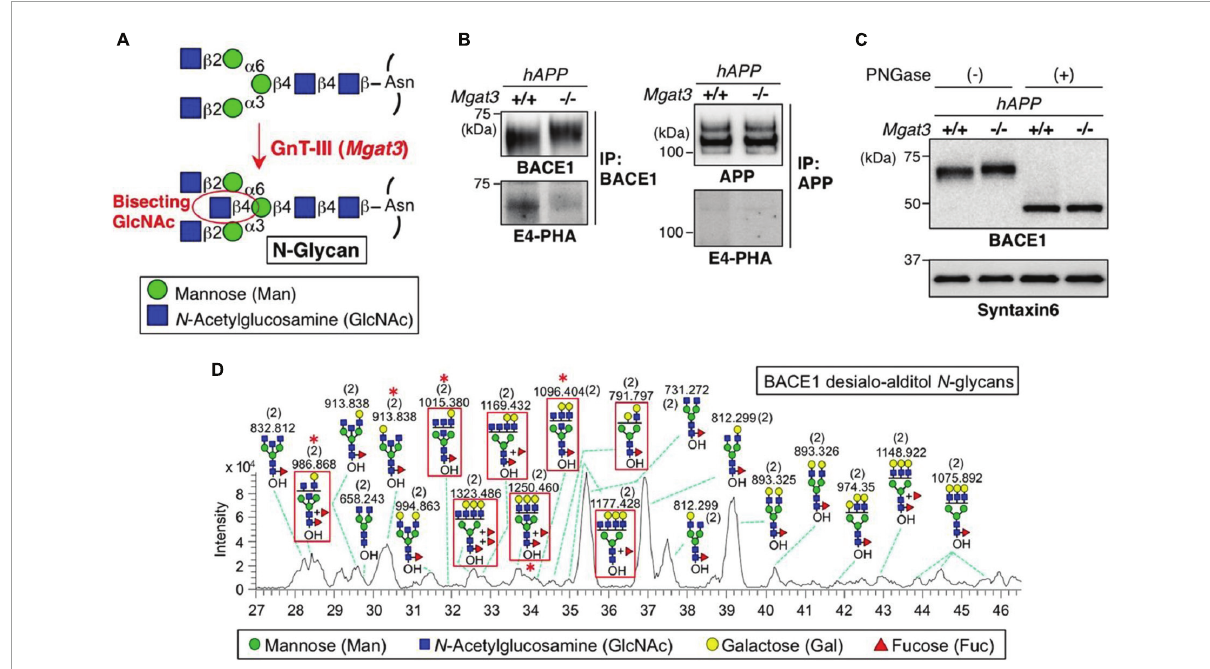
FIGURE3 BACE1 is modified with bisecting GlcNAc in vivo . (A) Bisecting GlcNAc modification by GnT-III. (B) BACE1 or APP was immunoprecipitated from mouse brains and blotted with E4-PHA lectin (Lower) or anti-BACE1 or APP antibodies (Upper) . hAPP indicates the APP23 transgenic mouse model for AD. (C) Proteins from mouse brain membrane fractions were treated with or without PNGase F and then immunoblotted for BACE1 or for syntaxin 6 (loading control). (D) LC–MS base peak chromatogram of desialo-alditol N-glycans derived from mouse brain BACE1. To simplify the results, N-glycans were chemically desialylated before LC–MS analysis. BACE1-specific glycans, judged by comparison with N-glycan structures from anti-BACE1 IgG, are highlighted by red squares. Asterisks indicate glycans demonstrated by MS/MS analysis to contain a bisecting GlcNAc structure. Numbers in parentheses indicate the charge state. Reprinted with the permissions from Kizuka et al.